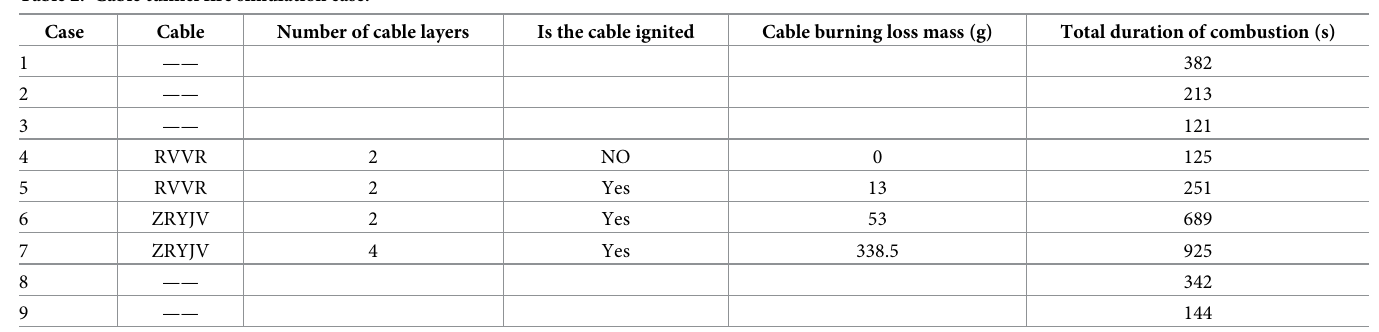
Table 2. Cable tunnel fire simulation case.